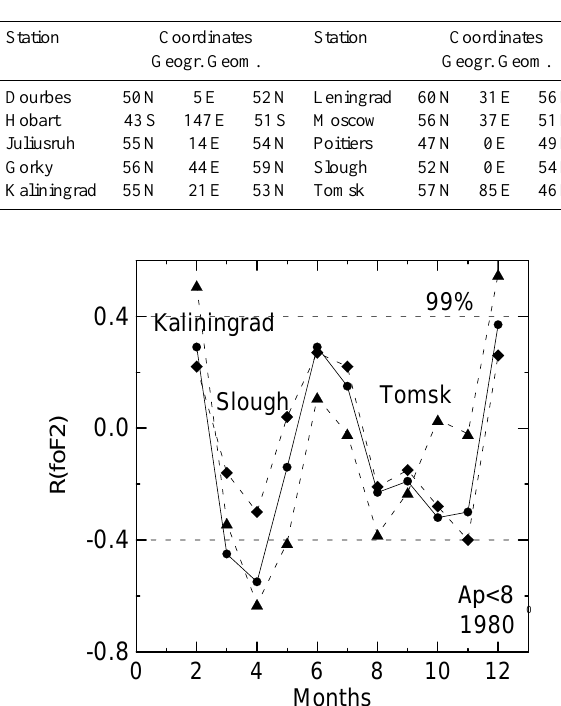
Fig. 1. Variations in R ( fo F2) over the year for 3 stations: Kalin- ingrad (circles), Slough(diamonds), and Tomsk (triangles). Hori- zontal dashed lines show the values of R ( fo F2) needed to provide a 99% confidence level according to the Fisher’s F parameter test.